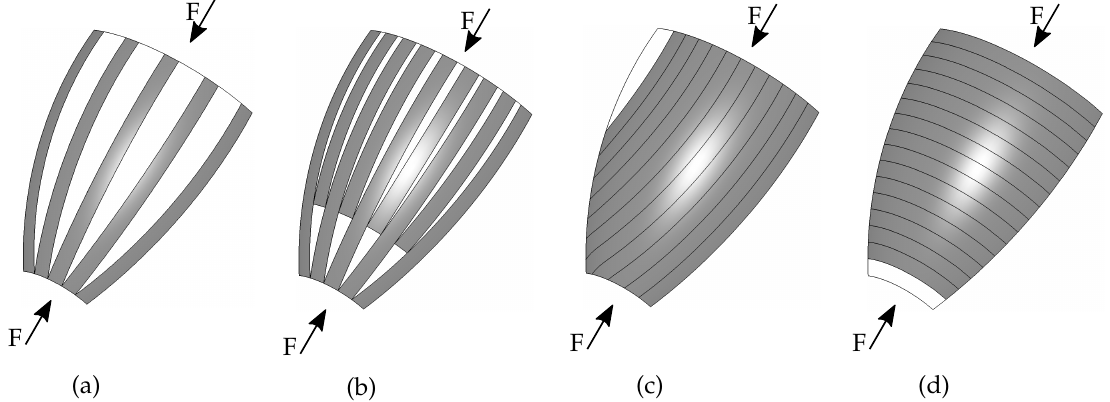
Figure 2. Placement strategies on double-curved surfaces. ( a ) Fixed form strategy; ( b ) Combined strategy; ( c ) Vertical strategy; ( d ) Horizontal strategy.